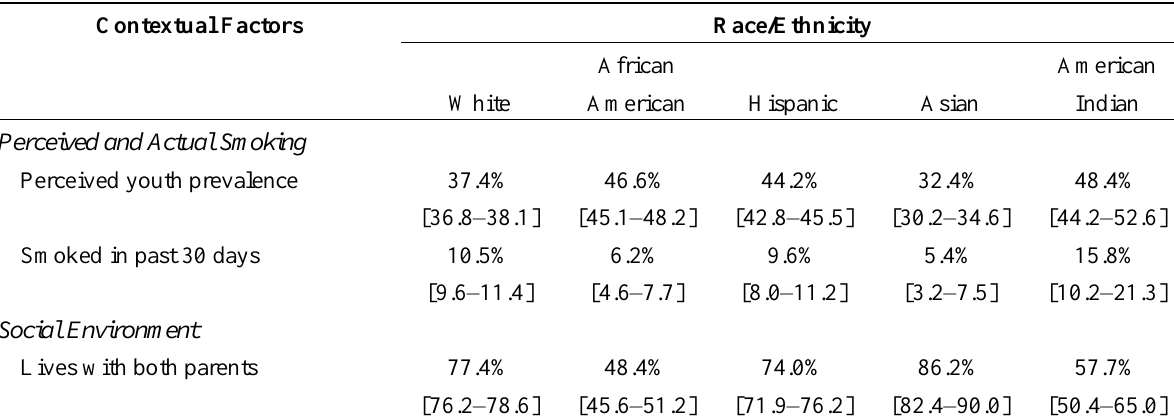
Table 1. Descriptive statistics showing exposure to contextual